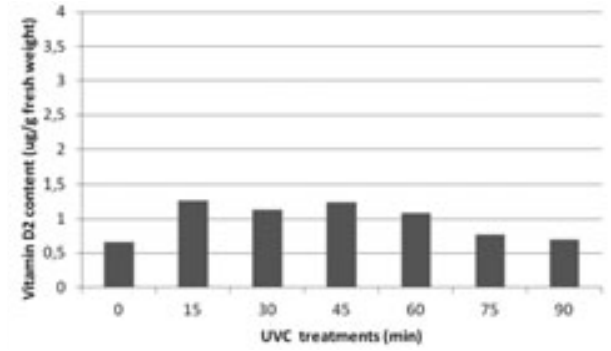
content in oyster mushrooms after 0 to 90 2